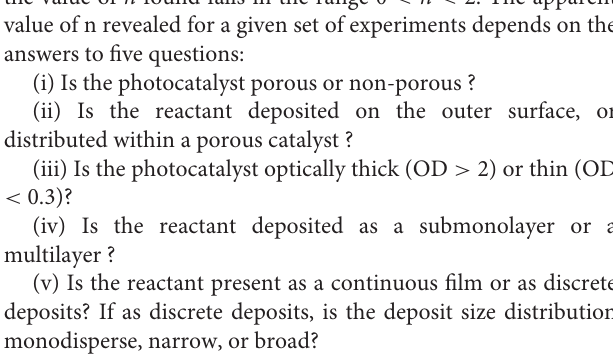
where k dye , k i , are the second order rate constants for reaction of dye and intermediates, i, respectively with the rate limiting oxidant, e.g., OH radical. Since the k i s are expected to be similar, the denominator is expected to be relatively constant (the sum term grows as the dye concentration term decreases over time, and the denominator will remain approximately constant). As a result, the reaction rate, proportional to OH × f dye , will exhibit an apparent first order behavior over time, even while the initial rate is zero order within the concentration range